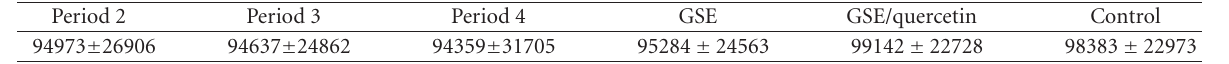
Table 7. E ff ect of GSE and GSE/quercetin on oxidised LDL levels U/L; N = 35, mean